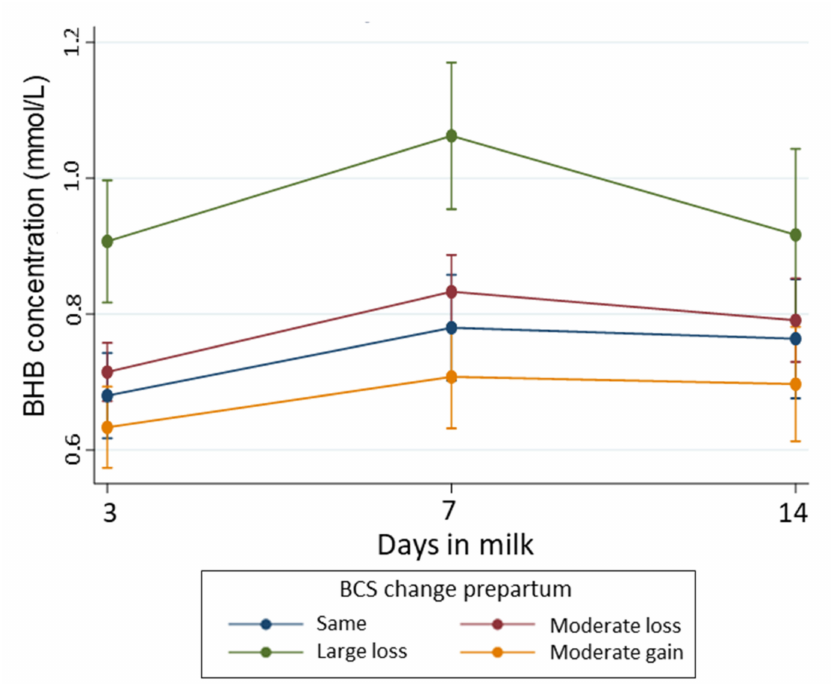
Figure 3. Temporal pattern of BHB concentration (with 95% confidence interval) during early lactation according to BCS change as the explanatory variable and adjusting for BCS at baseline ( − 21 days), parity, time, the interaction between BCS change and time, and interaction between parity and time. BCS change was calculated subtracting the BCS at − 21 days prepartum from the BCS measured around calving, and categorized as gain ( ∆ BCS 0 to 0.5), no change ( ∆ BCS = 0—reference), moderate loss ( ∆ BCS range: − 0.5 to < 0), or large loss ( ∆ BCS > − 0.5). Number of cows with moderate gain = 130; no-change = 117, moderate loss = 247, and large loss =